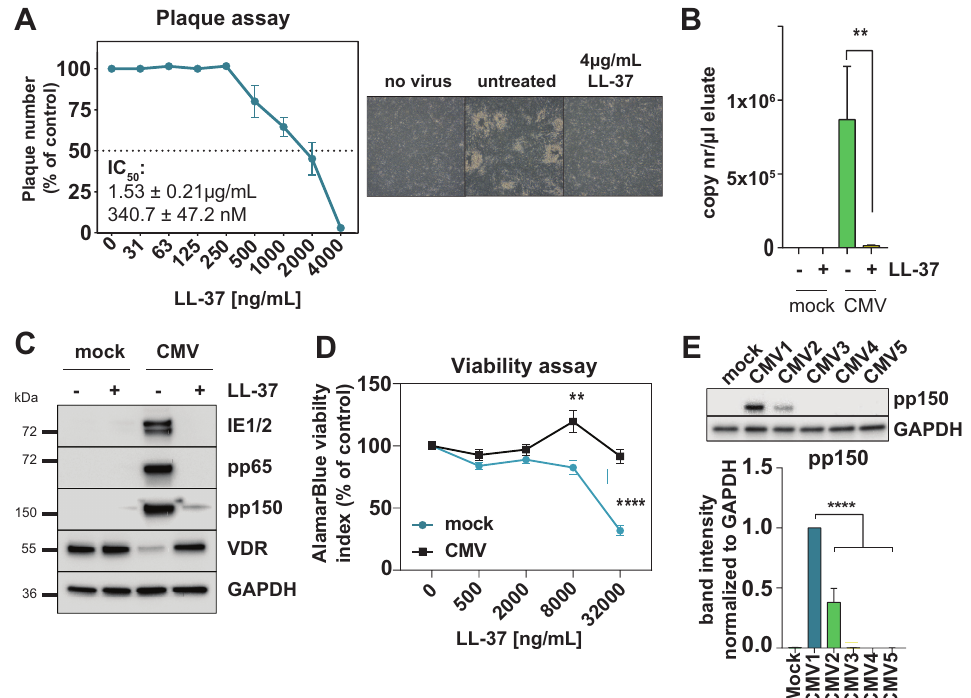
Figure 6. Cathelicidin inhibits HCMV replication. ( A ) Plaque reduction assay of HFF infected with HCMV AD169 pre-treated with increasing amounts of LL-37; percentage compared to DMSO control is shown (n = 2). Light microscope pictures of representative areas for the non-infected control, virus control and maximum LL-37 concentration are shown on the right. ( B ) Intracellular CMV DNA was detected in lysates from infected HFF at 72 h p.i. and 4 µ g/mL LL-37 (where indicated) using primers specific for the UL83 (pp65) gene. Quantification of copy numbers per measured sample were calculated by interpolation of values against a 5-point standard curve of pcDNA-pp65 plasmid dilutions. ( C ) Western blot showing abundance of the indicated proteins in whole cell lysate (WCL) from mock-infected or HCMV-infected HFF at 96 h p.i with or without treatment with 4 µ g/mL LL-37 peptide. Representative of three independent experiments. ( D ) AlamarBlue viability assay showing reduction in the viability index in mock- and CMV-infected cells treated with up to 32 µ g/mL LL-37 compared to the respective untreated control. ( E ) Western blot (left) and quantification (right) of pp150 relative protein abundance in cell lysates harvested at 96 h p.i. at MOI 0.05. HFF cells were either left untreated (mock, CMV1) or LL-37-treatment conditions (4 µ g/mL, CMV2 to CMV5). LL-37 was either added to the medium 2 h after inoculation (CMV2), or incubated for 1h with the cells prior to infection and then removed before adding the inoculum (CMV3). CMV4: LL-37 was incubated